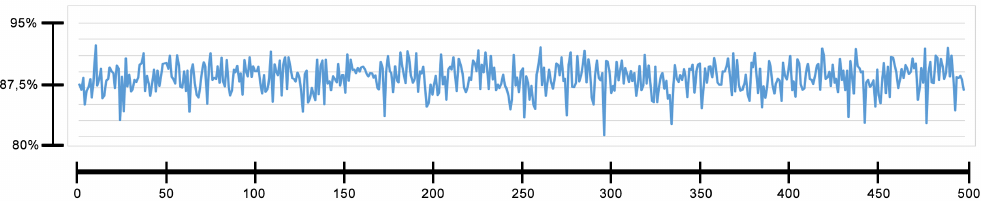
Figure 9. Line chart that shows the average fitness over the generations for individuals with fitness different from 0%.